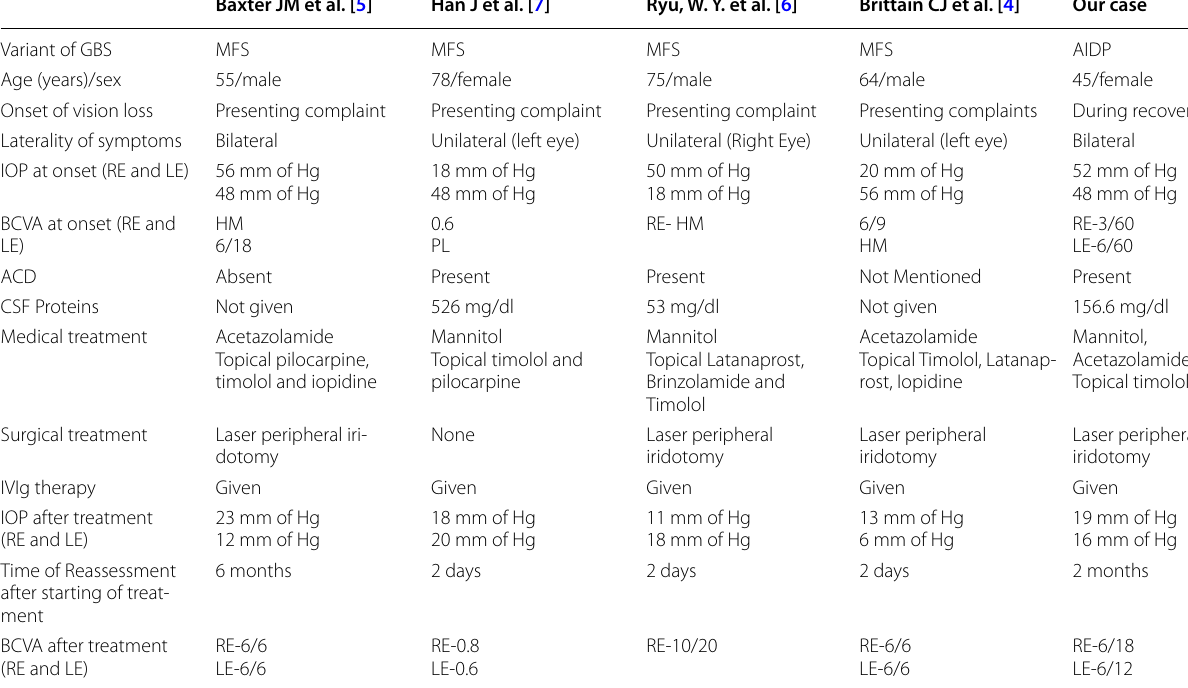
Table 1 Summary of cases reported in literature of vision loss in GBS due to Angle closure glaucoma